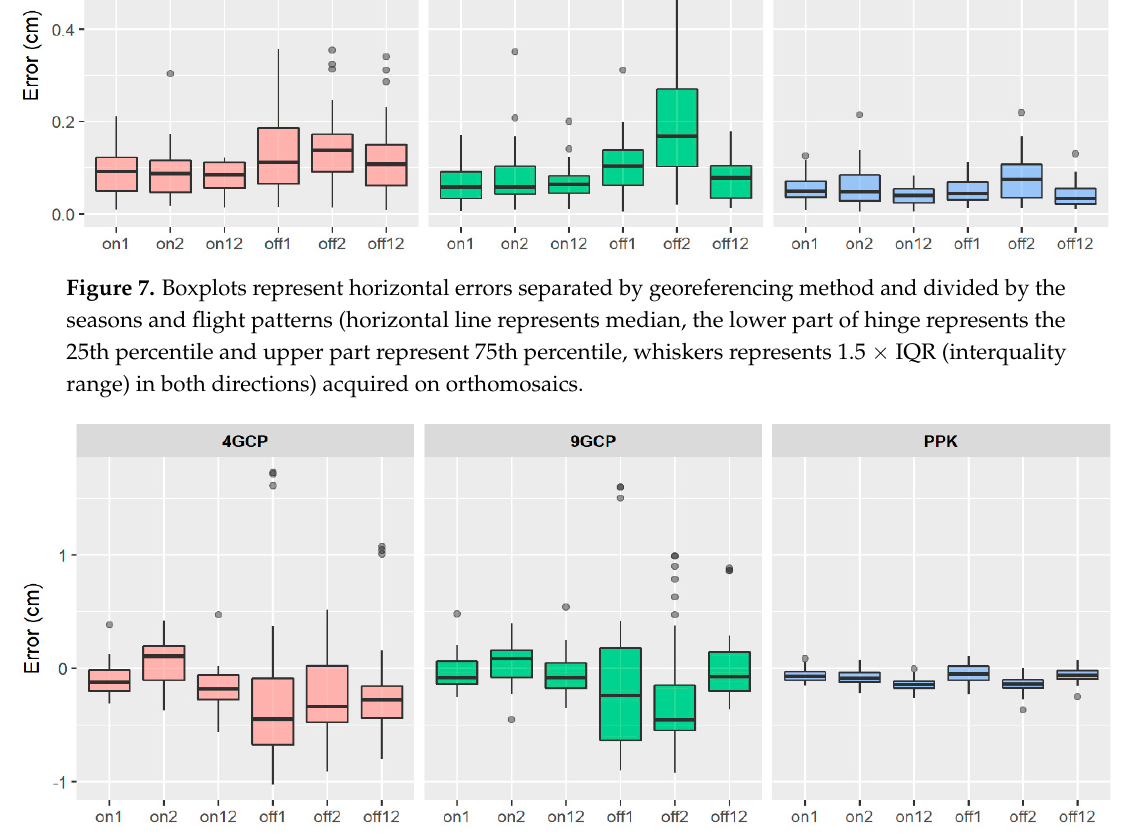
Figure 8. Boxplots represent horizontal errors separated by georeferencing method and divided by the seasons and flight patterns (horizontal line represents median, the lower part of hinge represents the 25th percentile and upper part represent 75th percentile, whiskers represents 1.5 × IQR (interquality range) in both directions) acquired on digital elevation models.